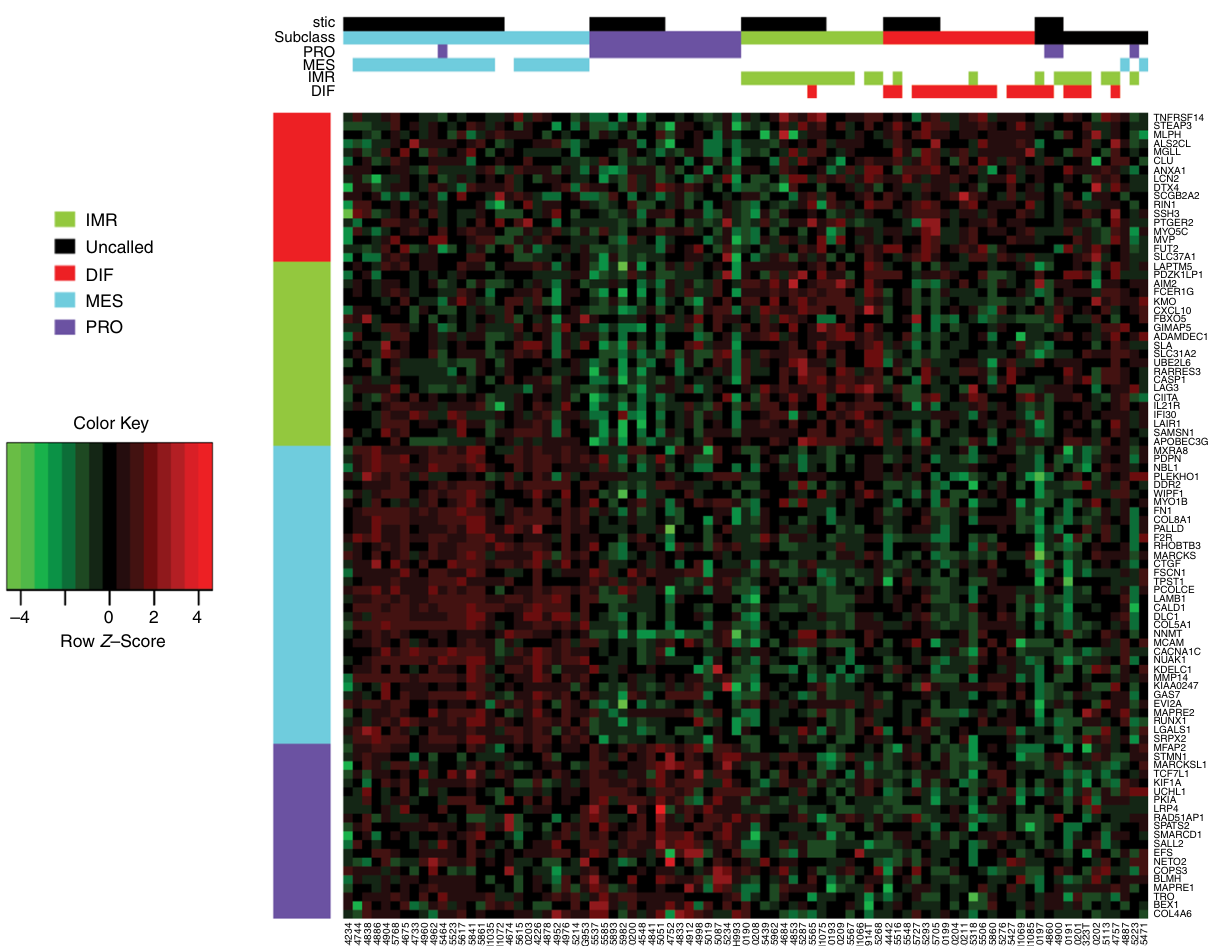
Fig. 5 TCGA features of study samples using a gene expression subtype signature. Gene expression using a 100 gene subtype signature and ordered by assigned subtype. Group membership is assigned by color in the top rows for subtypes with > 0.2 correlation. For samples with more than one robust correlation, the highest correlation was assigned if it was at least 1.5 × higher than the next highest subtype correlation. Samples to the far right were not assigned to any particular subtype. STIC status is shown in the top